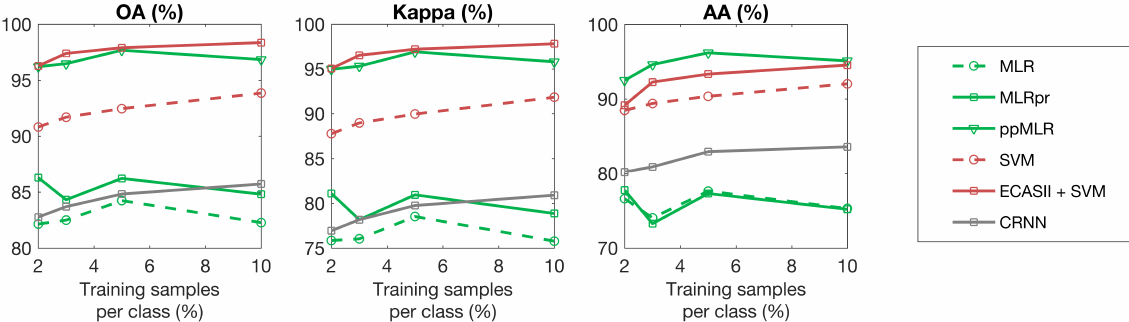
Figure 15. Classification accuracies (%) for different algorithms applied to the Pavia scene using different numbers of training samples.